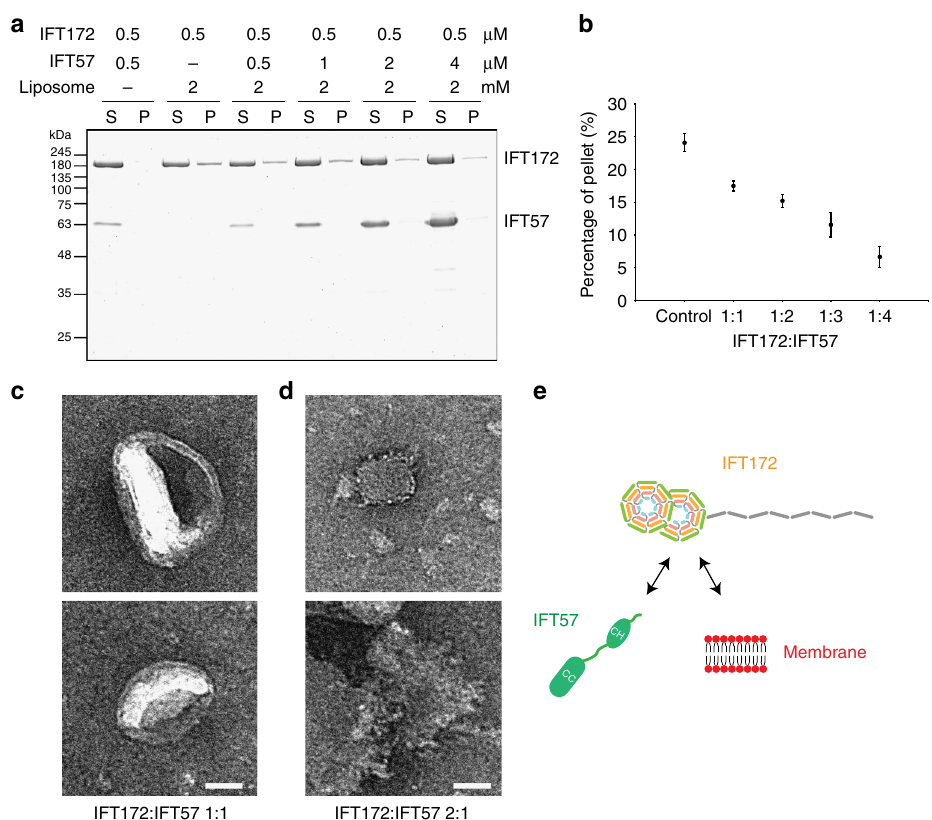
Fig. 7 IFT57 competes with membrane for binding to IFT172. a , b Co-sedimentation assay of IFT172 with Folch fraction I MLV in presence of IFT57. The quanti fi cation ( b ) shows the decrease of the amount of IFT172 in the pellet in the presence of IFT57. Error bars depict standard deviations from three separate experiments. These experiments were performed three independent times. c Negative-stain EM images of the IFT172/IFT57 dimer in 1:1 molar ratio with Folch fraction I liposomes show no remodeling of the membrane surface. Scale bar: 50 nm. d Negative-stain EM images of IFT172/IFT57 dimer in 2:1 molar ratio with Folch fraction I liposomes show the remodeling of the membrane surface. Scale bar: 50 nm. e Schematic representation of IFT172 interacting with IFT57 or